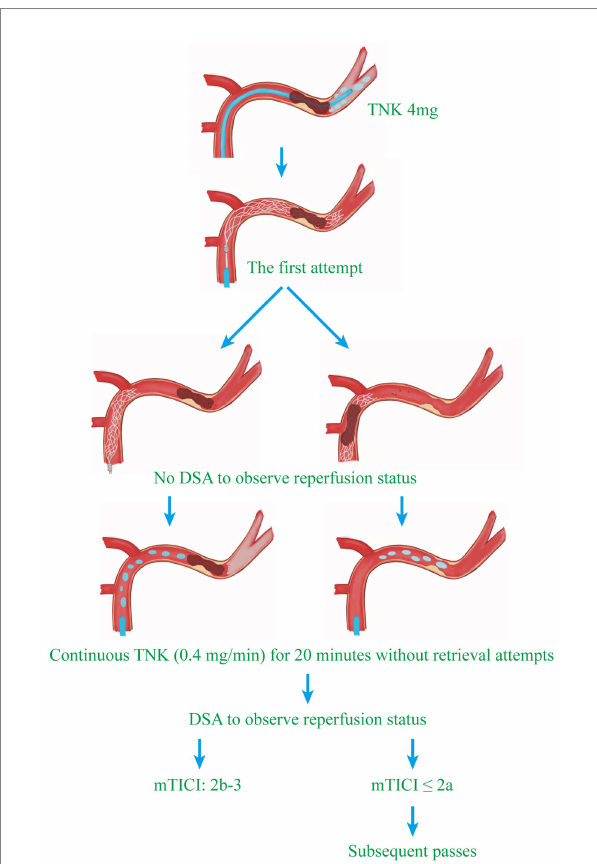
FIGURE 1 Flowchart of endovascular treatment procedures. The strategy of intra-arterial TNK administration in this study was composed of two steps. The first step was an infusion of 4 mg TNK after the microcatheter navigation across the clot. Then, a stent retriever device was deployed through the microcatheter from distal to proximal across the site of occlusion. The second step was an infusion of intra-arterial TNK (0.4 mg/min) continuously for 20 min after the first retrieval attempt. A DSA was performed to determine the status of the occluded vessel. If successful reperfusion was not achieved, subsequent passes were performed according to standard